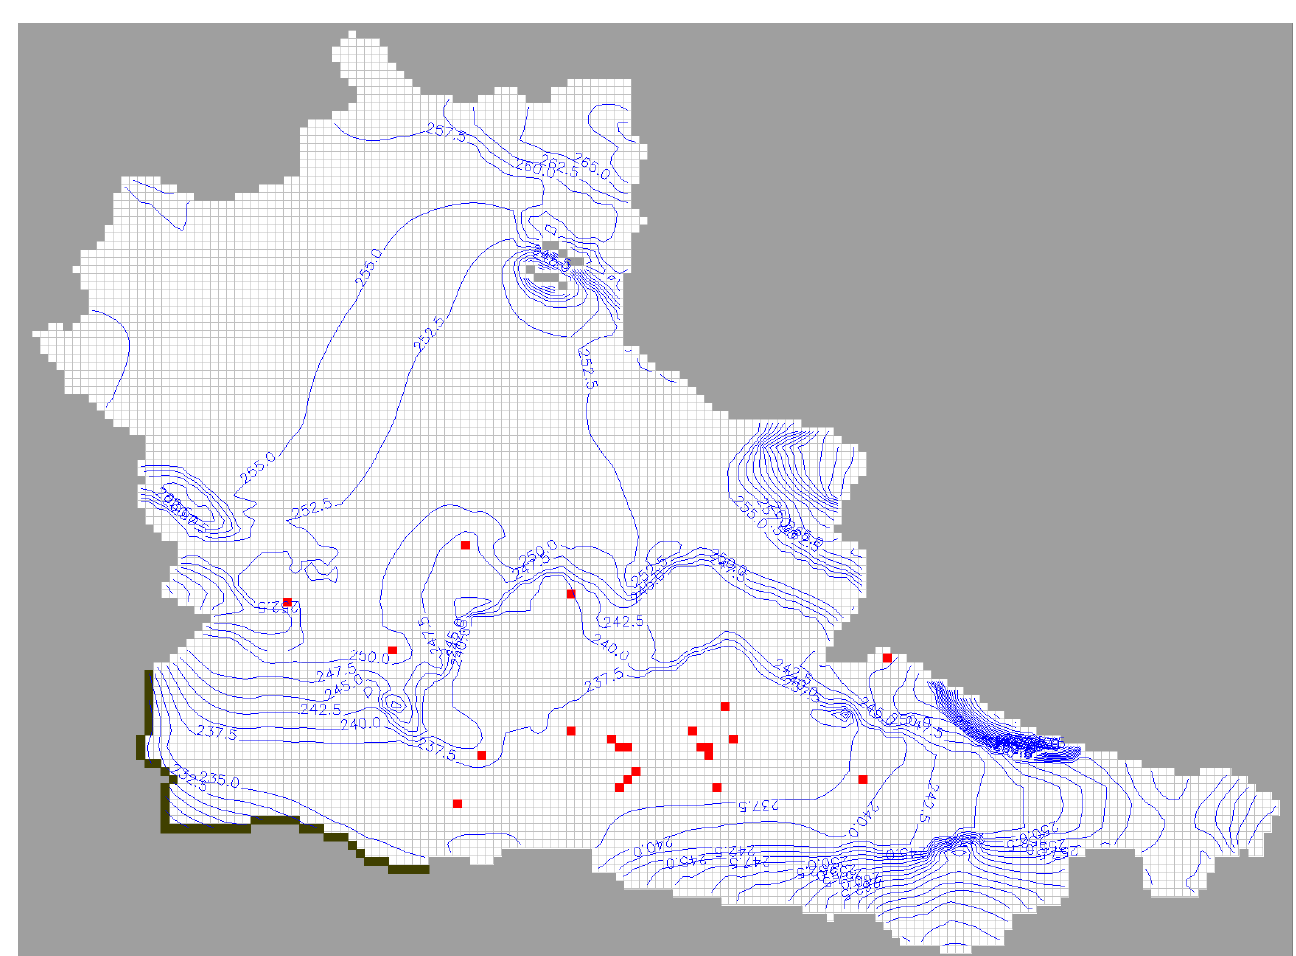
Figure 11. Hydrodynamic field distribution (blue lines—groundwater table contours in m a.s.l.) of the principal useful aquifer (Layer 3). Variant 0—calibrated state (mid-2017).